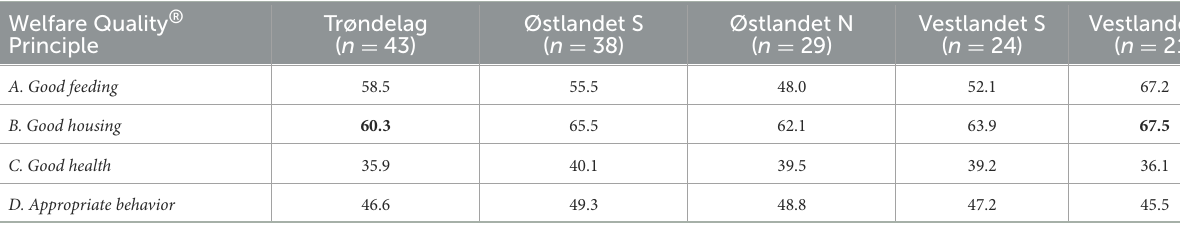
TABLE 6 Summary of estimated mean regional Welfare Quality ® principle scores based on the generalized linear models A. Good feeding, B. Good housing, C. Good health, and D. Appropriate behavior.